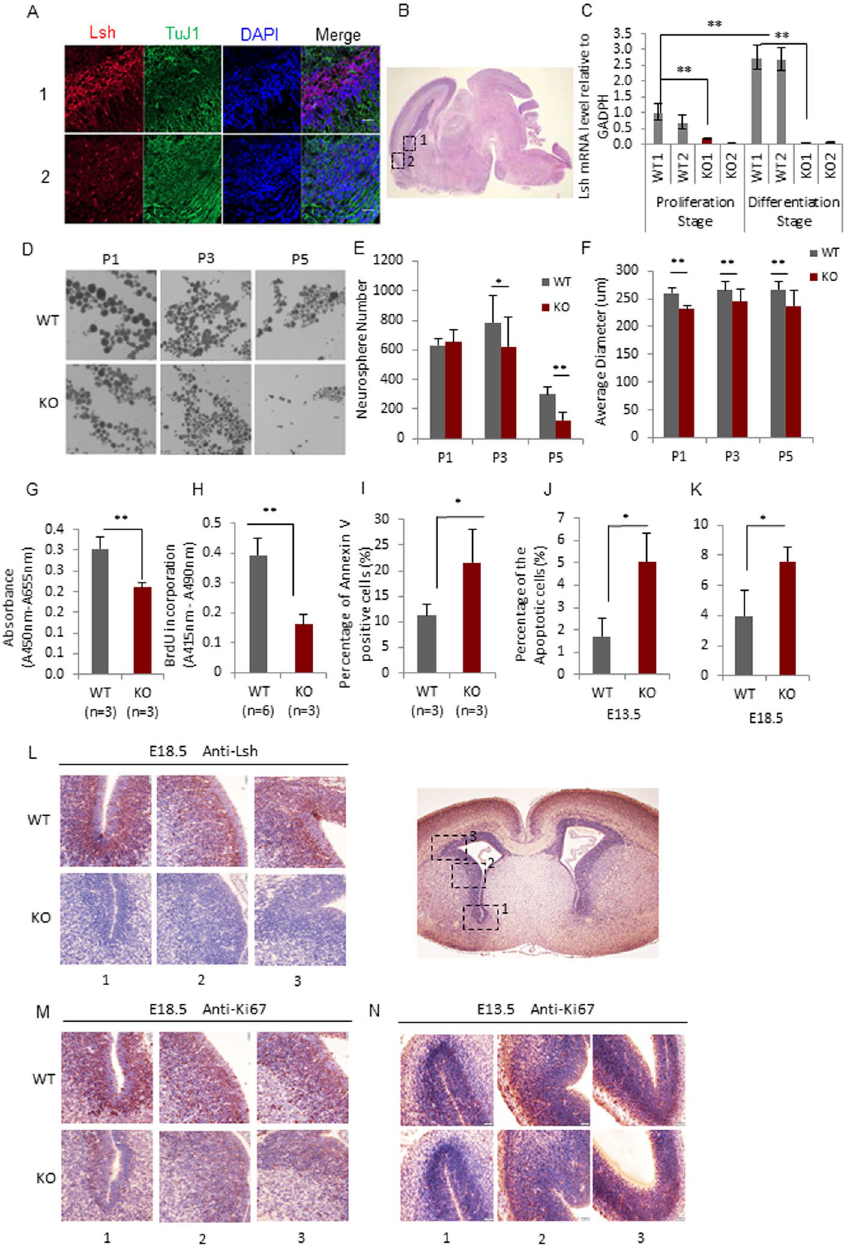
Figure 1. Lsh is required for proliferation and self-renewal of NSPCs. ( A ) Immunofluorescence for detection of Lsh and Tuj1 in E18.5 (day 18.5 gestation) embryonic brain sections. Magnificence: 40x, Scale bar, 20 μ m. ( B ) A representative sagittal section of the embryonic brain, the number labeled areas are shown in higher magnification in ( A ). ( C ) Lsh mRNA evaluation by RT-qPCR during NSPCs proliferation and differentiation in vitro . Gapdh served as internal control, expression levels were relative to WT1 at the proliferation stage. ( D ) Representative phase contrast images for neurospheres at passage 1, 3 and 5. ( E and F ). Quantification analysis of neurosphere numbers ( E ) and the average diameter ( F ) in WT and Lsh KO NSPCs at passage1, 3 and 5 (3 WT and 3 KO embryos were used, 5 technical repeats for each sample). ( G ) Cell viability assay by WST-1 in NSPCs cultures. ( H ) BrdU incorporation assay in NSPCs cultures. ( I ) Apoptotic cell measurement in NSPCs cultures by FACS. ( J and K ) Quantification of TUNEL assay on E13.5 ( J ) and E18.5 ( K ) brain tissue (SVZ) sections. Multiple SVZ areas were quantified by Image J (n = 4). ( L , M and N ) IHC by anti-Lsh and anti-Ki67 on E18.5 embryonic brain sections (n = 4). A representative transverse section of the embryonic brain is shown (4x), the number labeled areas are shown in higher magnification (40x) in ( L , M , N ). Brown signal indicates positive protein stains and blue represents the DAPI signals. Scale bar, 20 μ m. * p < 0.05, ** p < 0.001. Error bars represent